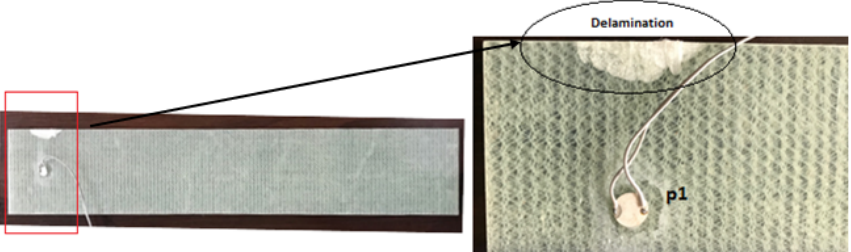
Figure 3. Composite beam with enlarged view showing delaminated region (S3).